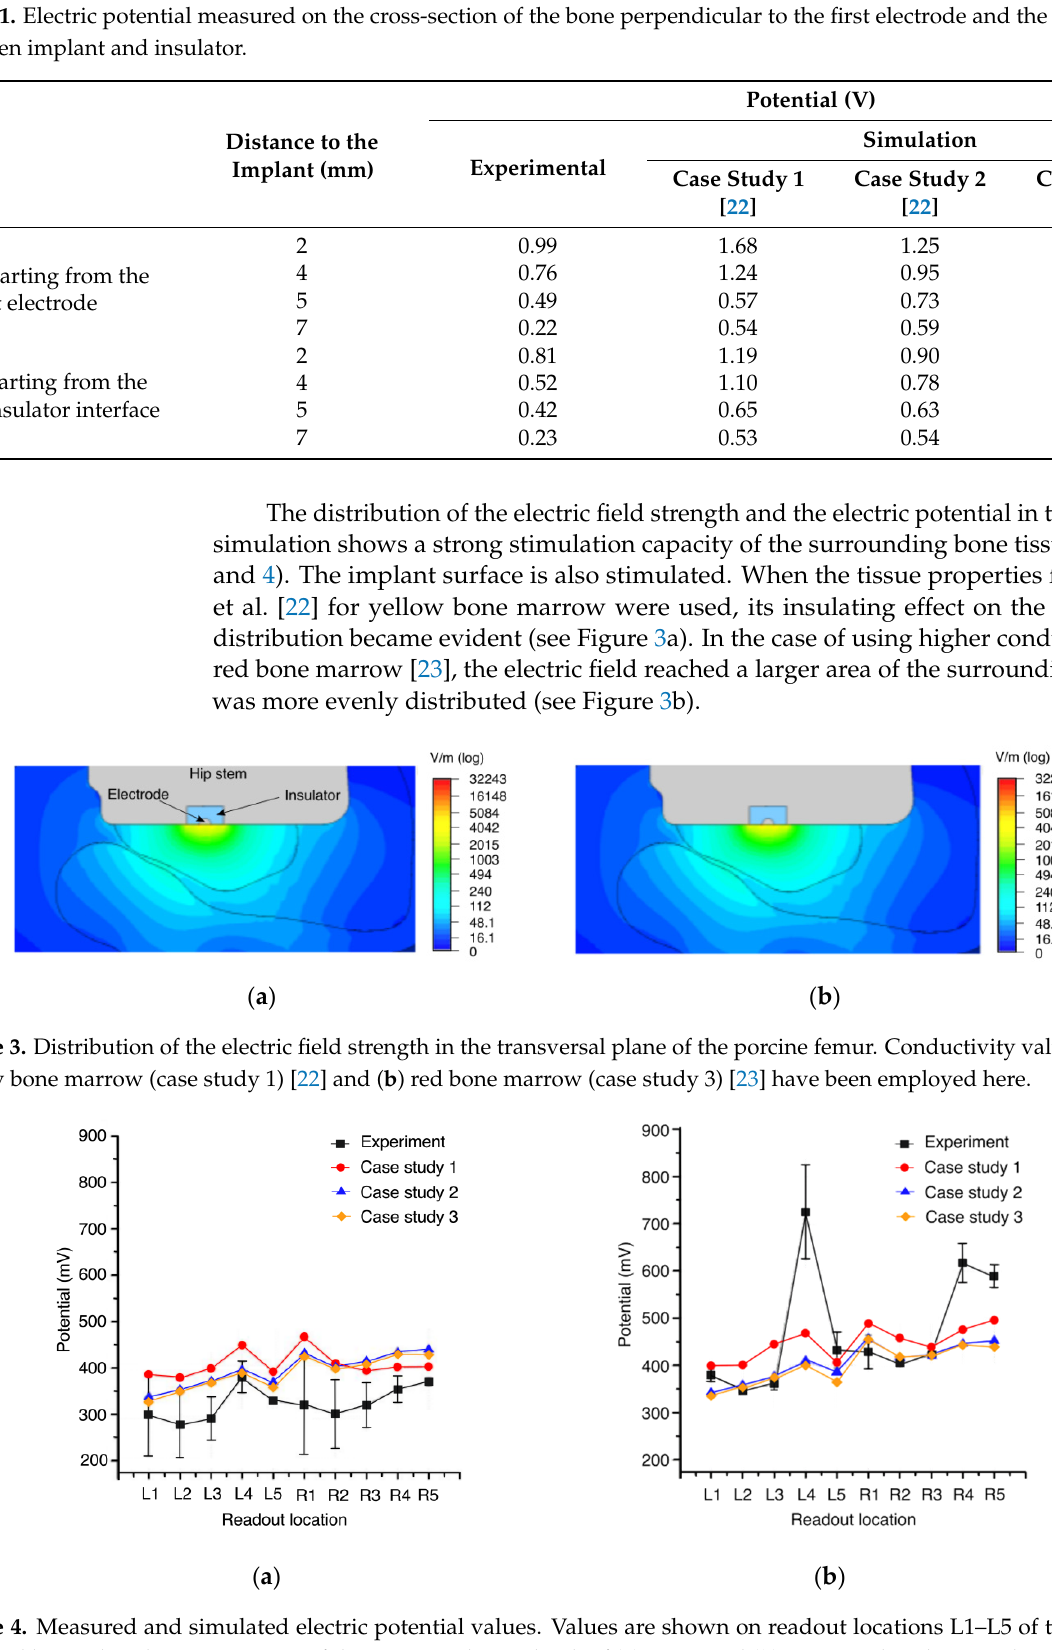
( b ) Figure 5. Electric field distribution obtained for case study 3. A voltage of ( a ) 6.0 V and ( b ) 0.2 V was applied at 20 Hz, representing clinical conditions. 4. Discussion In the present study, we investigated the general feasibility of an electrostimulative uncemented total hip stem. The bone, being in close proximity to the implant, provides most of the mechanical stability. For this reason, the area close to the implant is of highest interest and thus the electrical stimulation can be limited to the closest bone on both sides of the implant. Therefore, the electric potential values at the cross section of a porcine femur and along a defined raster along the porcine femur defined at depths of 5 mm and 8 mm into the bone were measured in an experiment and compared to results from three different numerical simulation scenarios. Based on two different conductivity values for bone marrow, three case studies were performed in order to discover the most precise model to replicate the physiological behavior of the bone. In the first simulation scenario